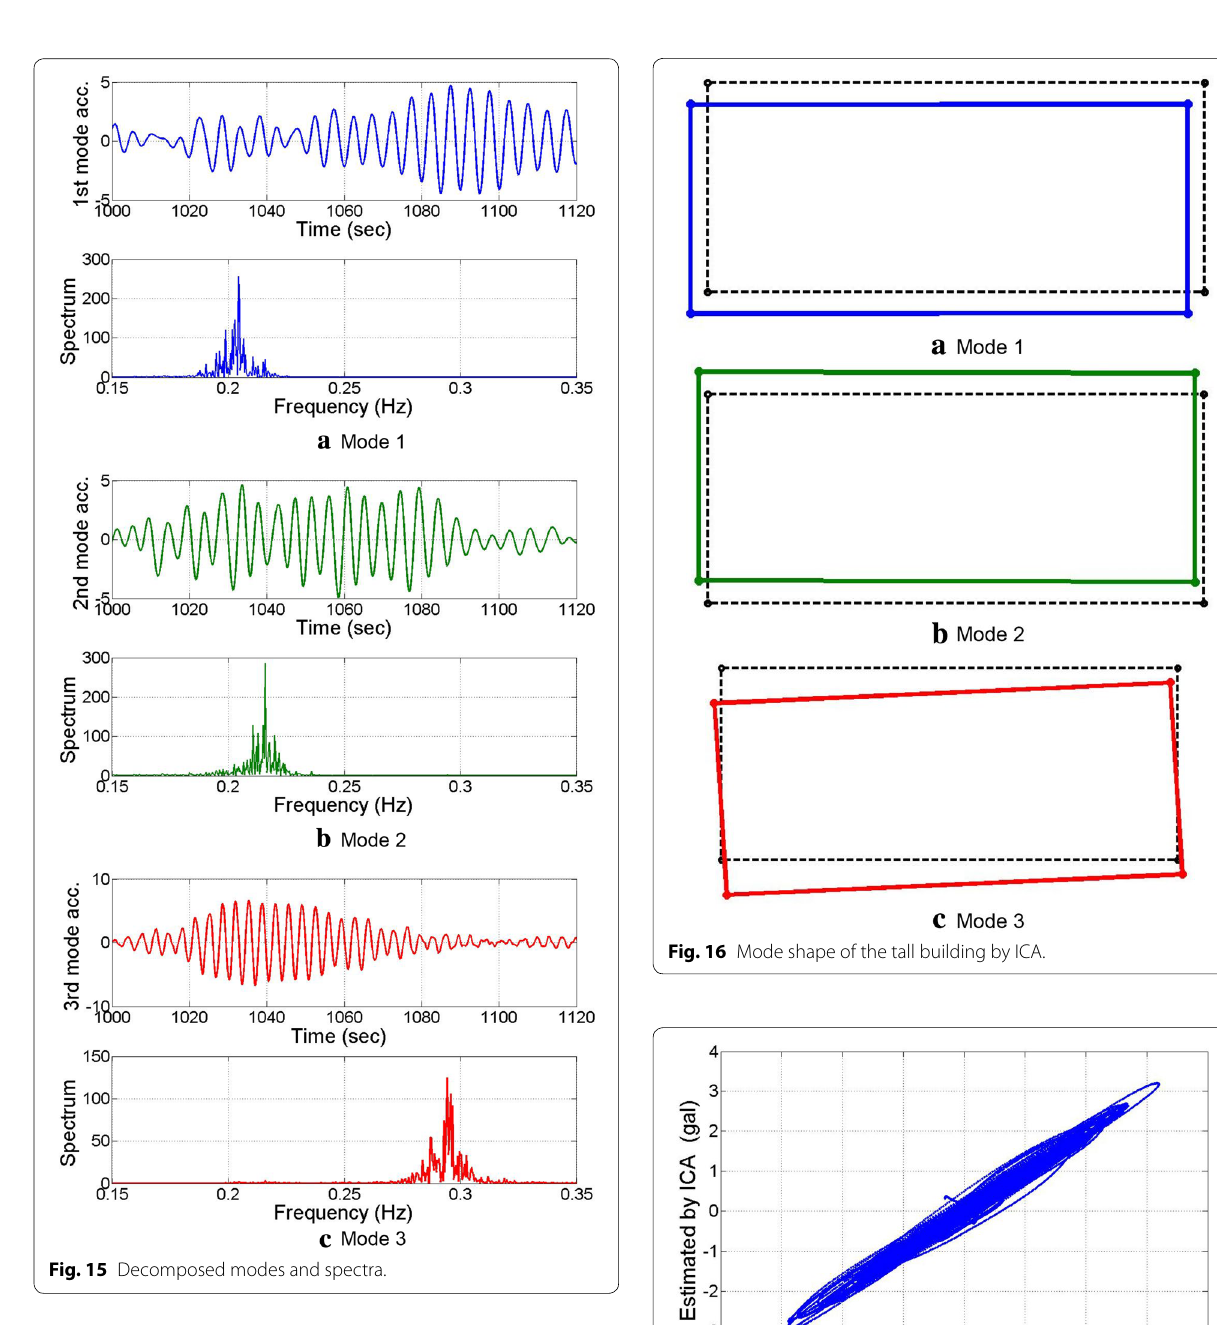
Table 7 Transform matrix and mode shape.